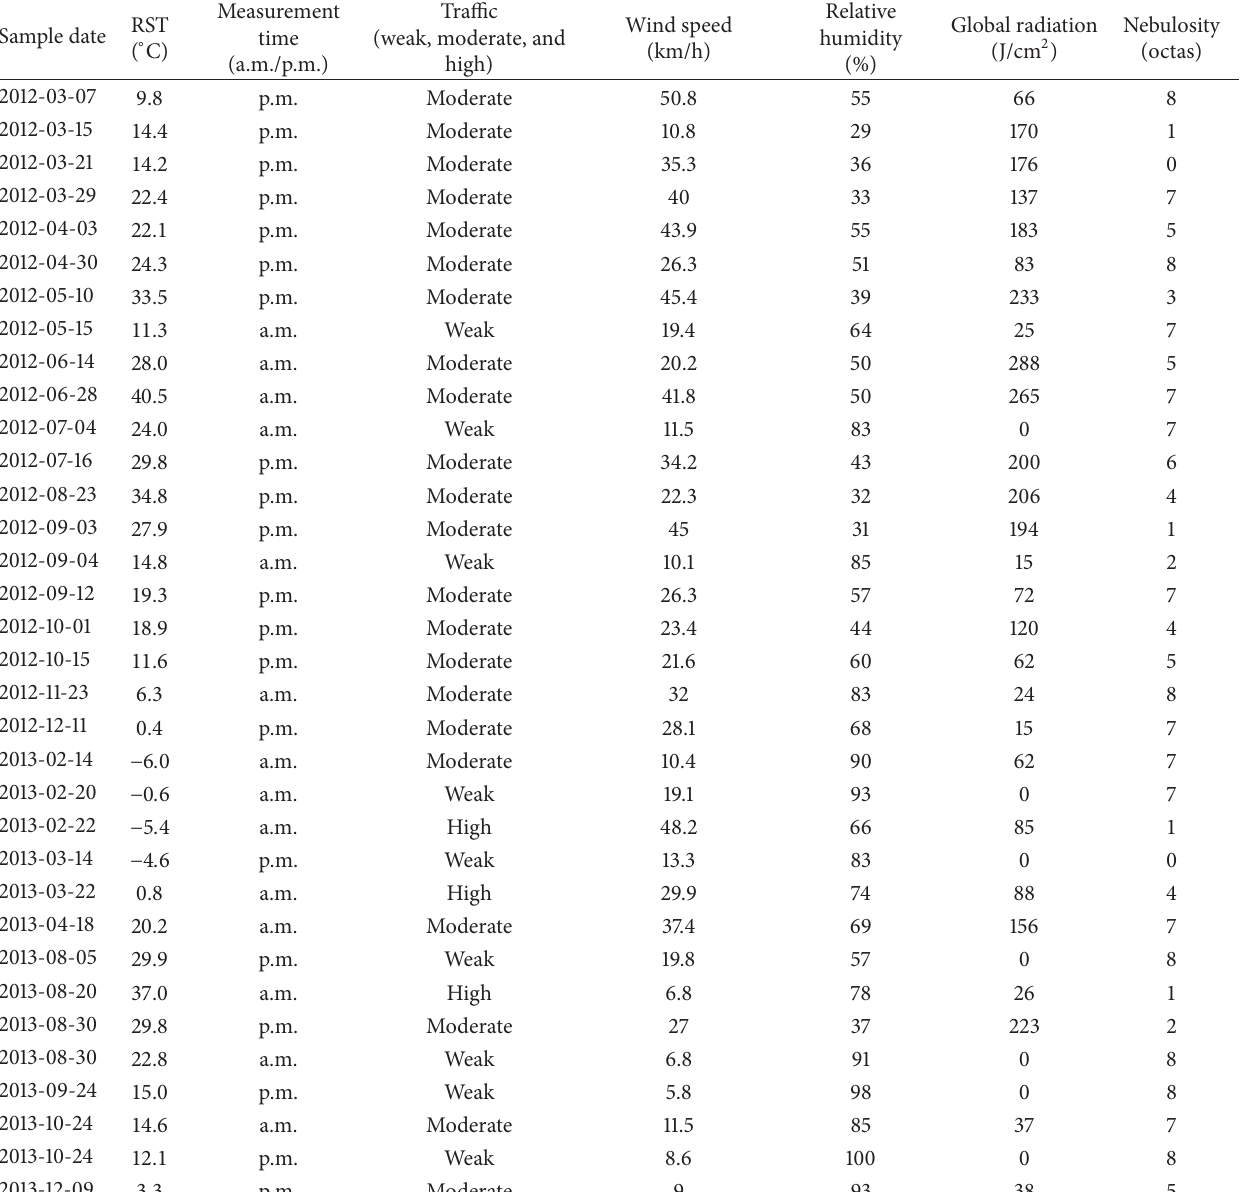
Table 1: List of variables used for PLS